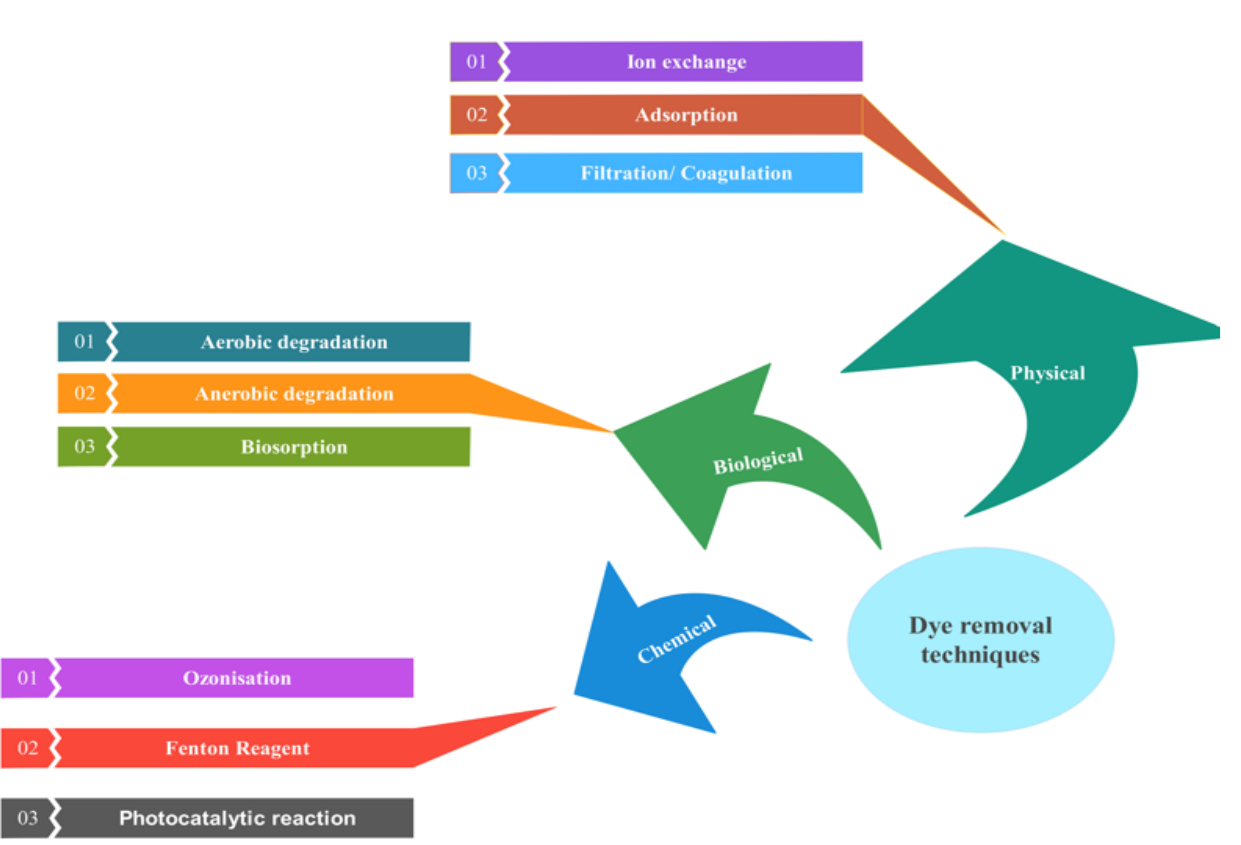
Figure 3. Different methodologies adopted for the removal of dyes.